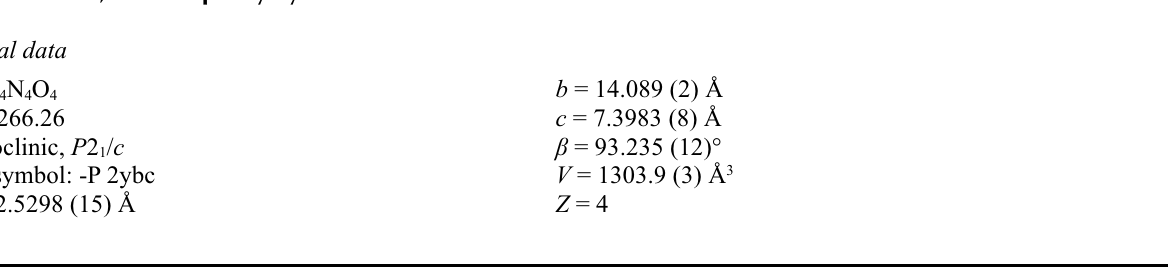
Figure 2 A diagram showing the partially overlapped arrangement of benzene rings [symmetry code: (i) 1 - x ,1 - y ,- z ]. 3-Pentanone